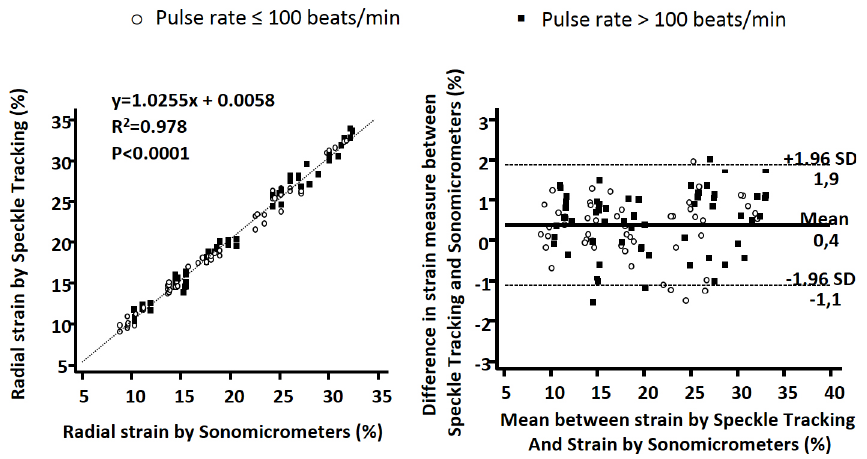
Fig 3. Correlation (left) and Bland-Altman analysis (right) of radial strain measurements between speckle tracking and